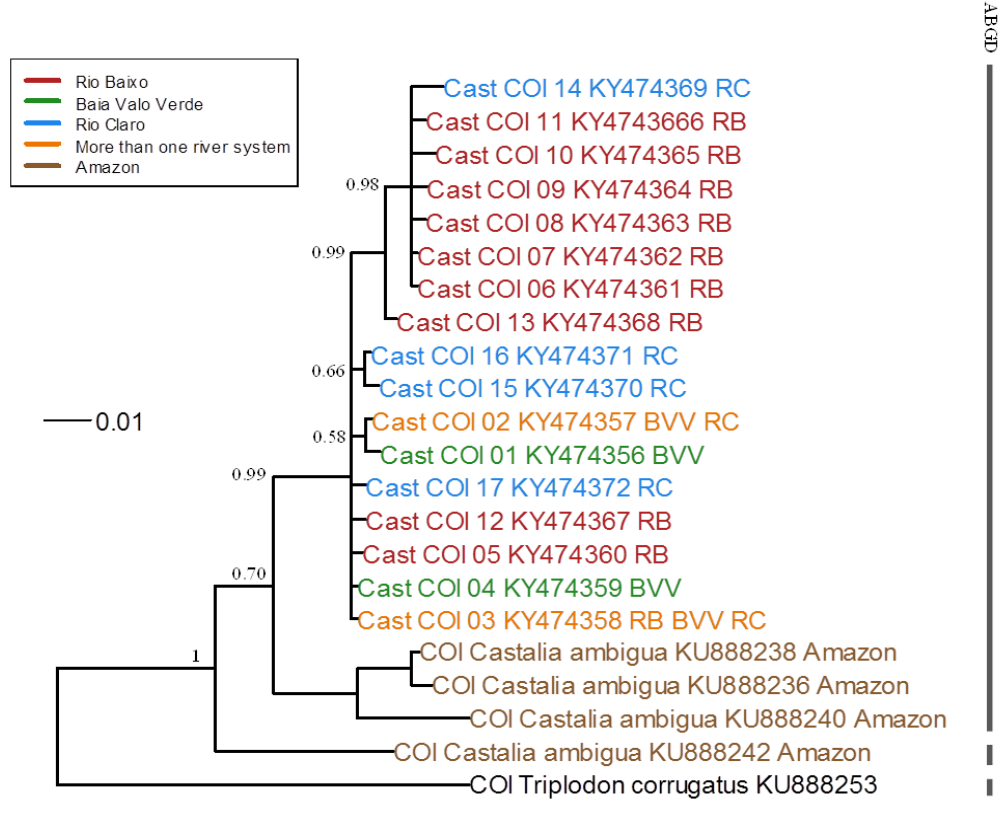
Figure 7. Bayesian phylogenetic analysis showing the relationships among the COI sequence haplotypes (KY474356–KY474372) and other 4 sequences for C. ambigua (KU888238, KU888236, KU888240, and KU888242) obtained from Genbank. The outgroup was Triplodon corrugatus (KU888253). The alignment of these sequences resulted in 454-bp DNA sequence. The analysis was run for 600,000 generations to create a set of trees, of which 9002 were sampled. The Bayesian phylogenetic consensus tree had a final average standard deviation of split frequencies of 0.006727 and with a -ln likelihood of −1212.66 Branch lengths are proportional to inferred evolutionary distances. Numerals to the left of nodes indicate posterior probability support for the respective nodes. Designators for each DNA sequence include the location (RC—Claro Stream, BVV—Vale Verde Lake, RB—Baixo Stream). The distance bar is shown in units of substitutions per nucleotide site. ABGD on the right margin refers to species delimitations suggested by Automatic Barcode Gap Discovery [57].